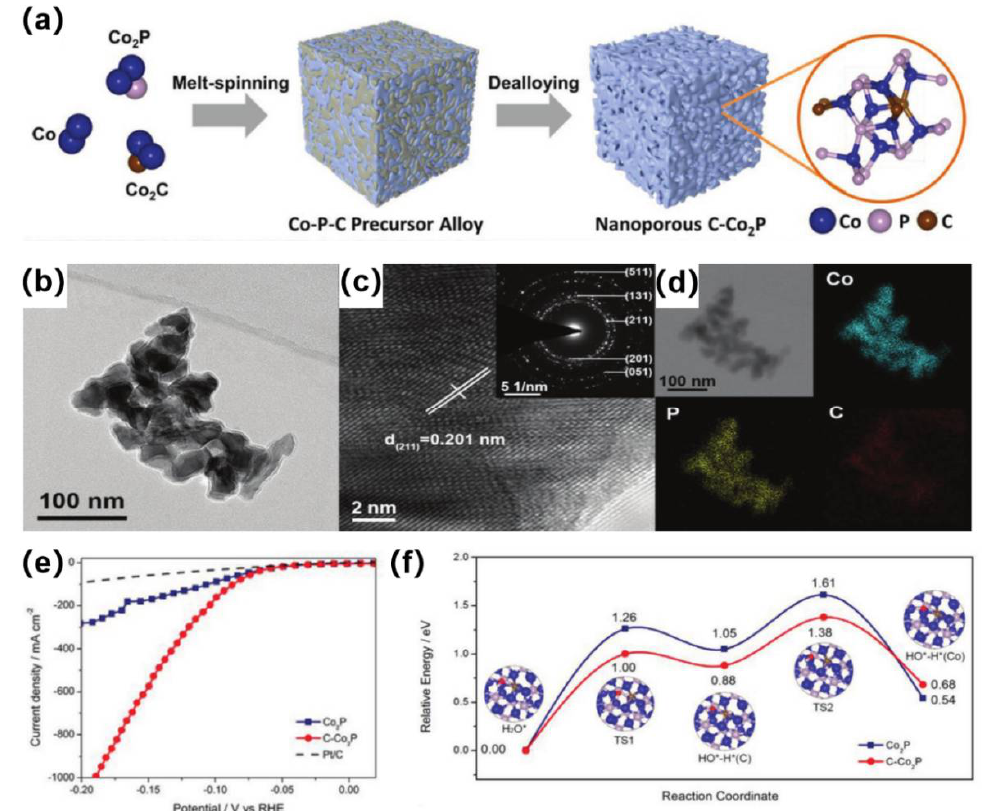
Figure 8. ( a ) Schematic of the preparation of nanoporous C-Co 2 P electrocatalysts, ( b ) TEM image, ( c ) HRTEM image, ( d ) the element distribution of nanoporous C-Co 2 P, ( e ) Polarization curves of the as-prepared catalysts in simulated alkaline seawater, and ( f ) The relative energy diagram along the proton-deliver pathway on Co 2 P and C-Co 2 P surfaces. Reproduced with permission from [28]. Copyright © 2021, Wiley-VCH GmbH.